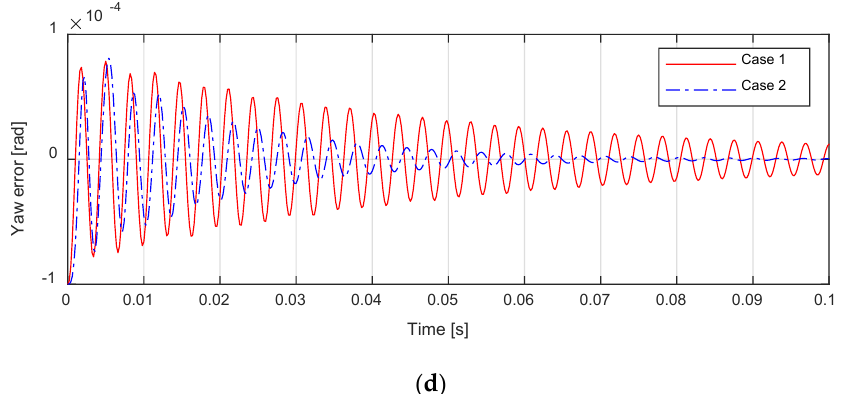
Figure 7. Position tracking performance of X − axis position and yaw. ( a ) X−axis position tracking performance. ( b ) X−axis position tracking performance (enlarged). ( c ) Yaw tracking performance. ( d ) Yaw tracking performance (enlarged).